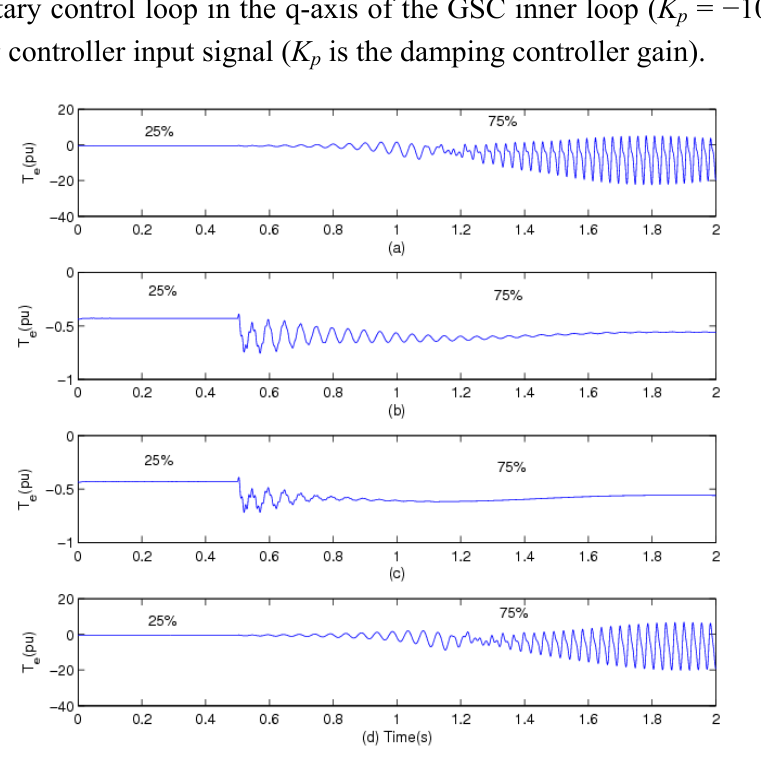
Figure 8. Dynamic responses of T ( b ) supplementary control loop in the d-axis of the GSC outer loop ( K ( c ) supplementary control loop in the d-axis of the GSC inner loop ( K